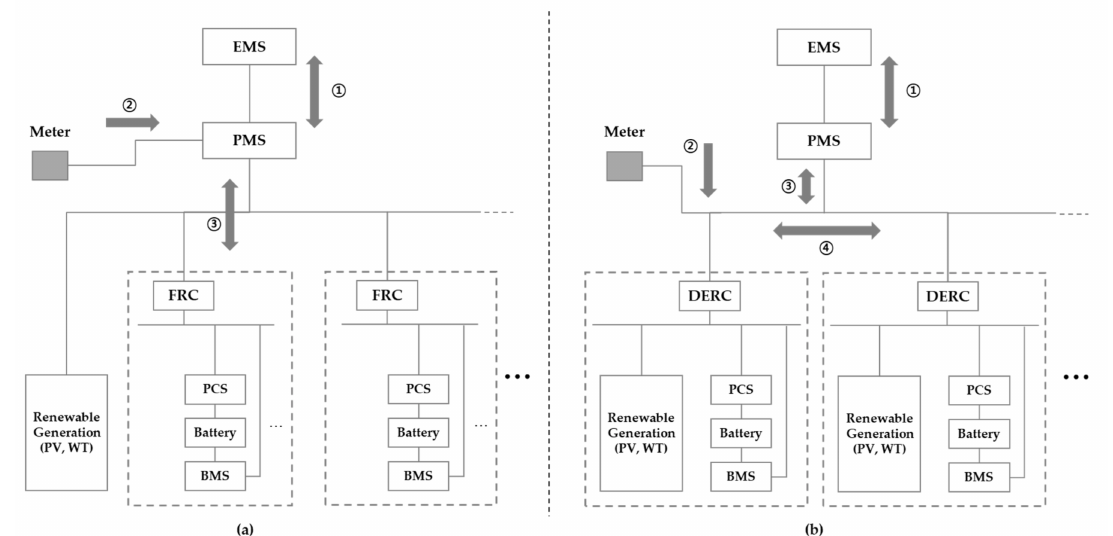
Figure 8. ( a ) Centralization control scheme and ( b ) DERC-based distributed autonomous control scheme of renewable generation and BESS for frequency